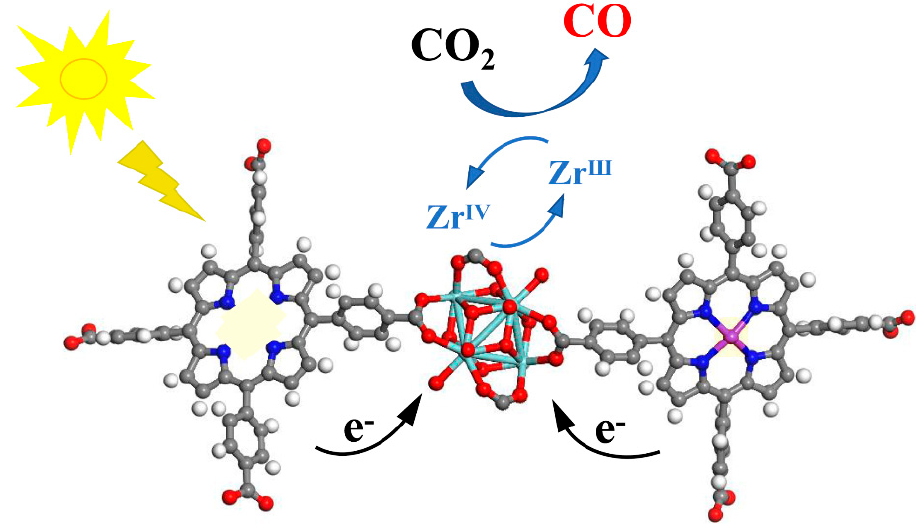
Figure 8. Proposed mechanism for the photocatalytic CO 2 reduction over PCN − 222(2H&M).